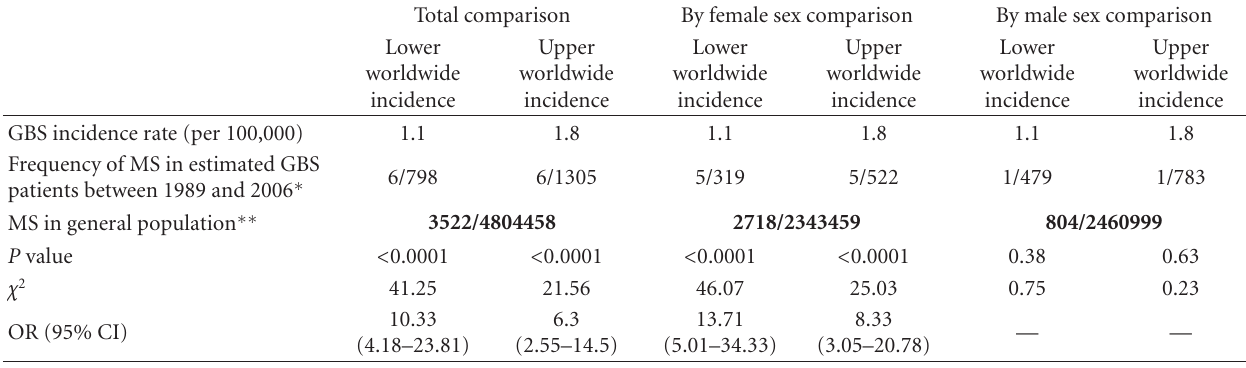
Table 2: Frequency of MS in the general population and in two estimated GBS populations; the comparison of two frequencies via χ 2